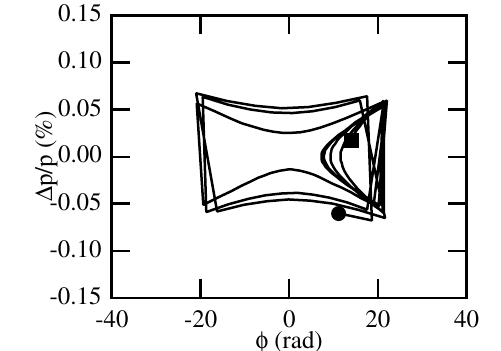
FIG. 10. Poincare´ map from 1 GeV (circle) to 3 GeV (square).